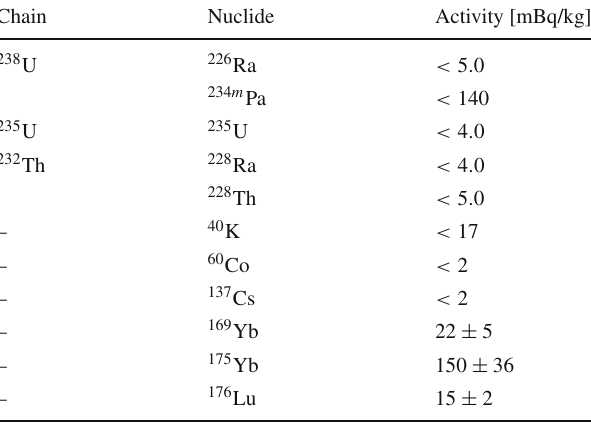
Fig. 2 Decay schemes of Yb isotopes with double beta decay and α - decay modes as investigated in this work. 168 Yb has multiple (cid:6)(cid:6) decay modes: 2 ν(cid:6)(cid:6) is only detectable if the decay goes to one of the excited states. 0 ν(cid:6)(cid:6) could also occur radiatively, adding a Bremsstrahlung γ - ray to the final state. The γ -ray energy depends on the atomic shells of